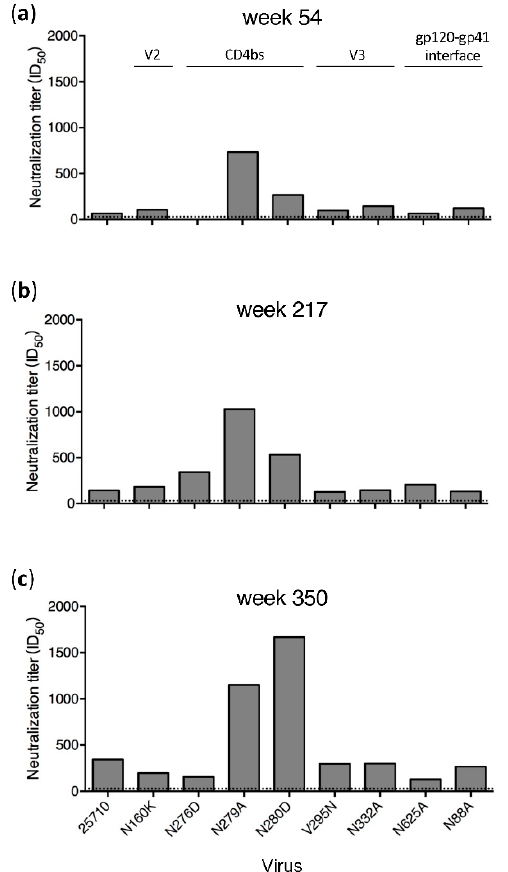
Figure 2. Neutralization specificities of longitudinal plasma from G1015R. Neutralization activities of plasma samples from weeks 54 ( a ), 217 ( b ) and 350 ( c ) post infection from G1015R were determined using the wild type 25710 and its env mutants (N88A, N160K, N276D, N279A, N280D, V295N, N332A and N625A). The dotted line indicates the lowest dilution (1:30) for the neutralization assay.